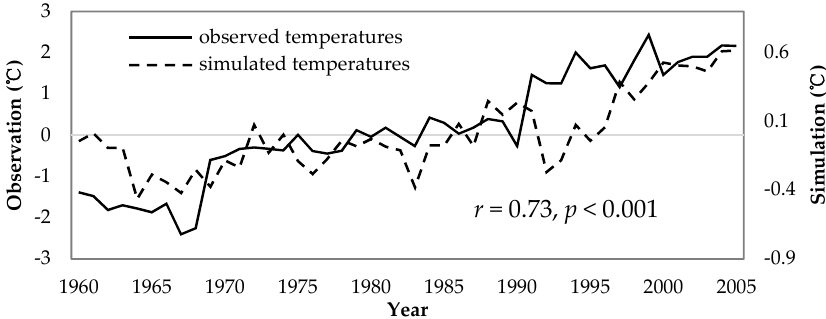
Figure 3. Comparison of simulated annual mean temperature and observed annual mean temperature from 1960 to 2005.